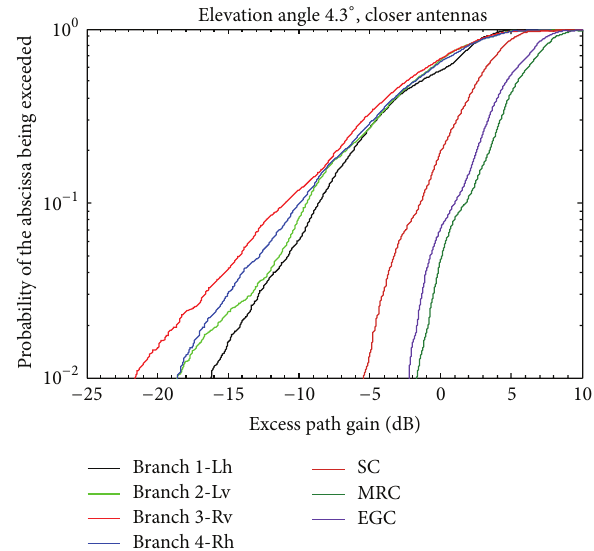
— Figure 3: CDF of normalized series and combined signals.